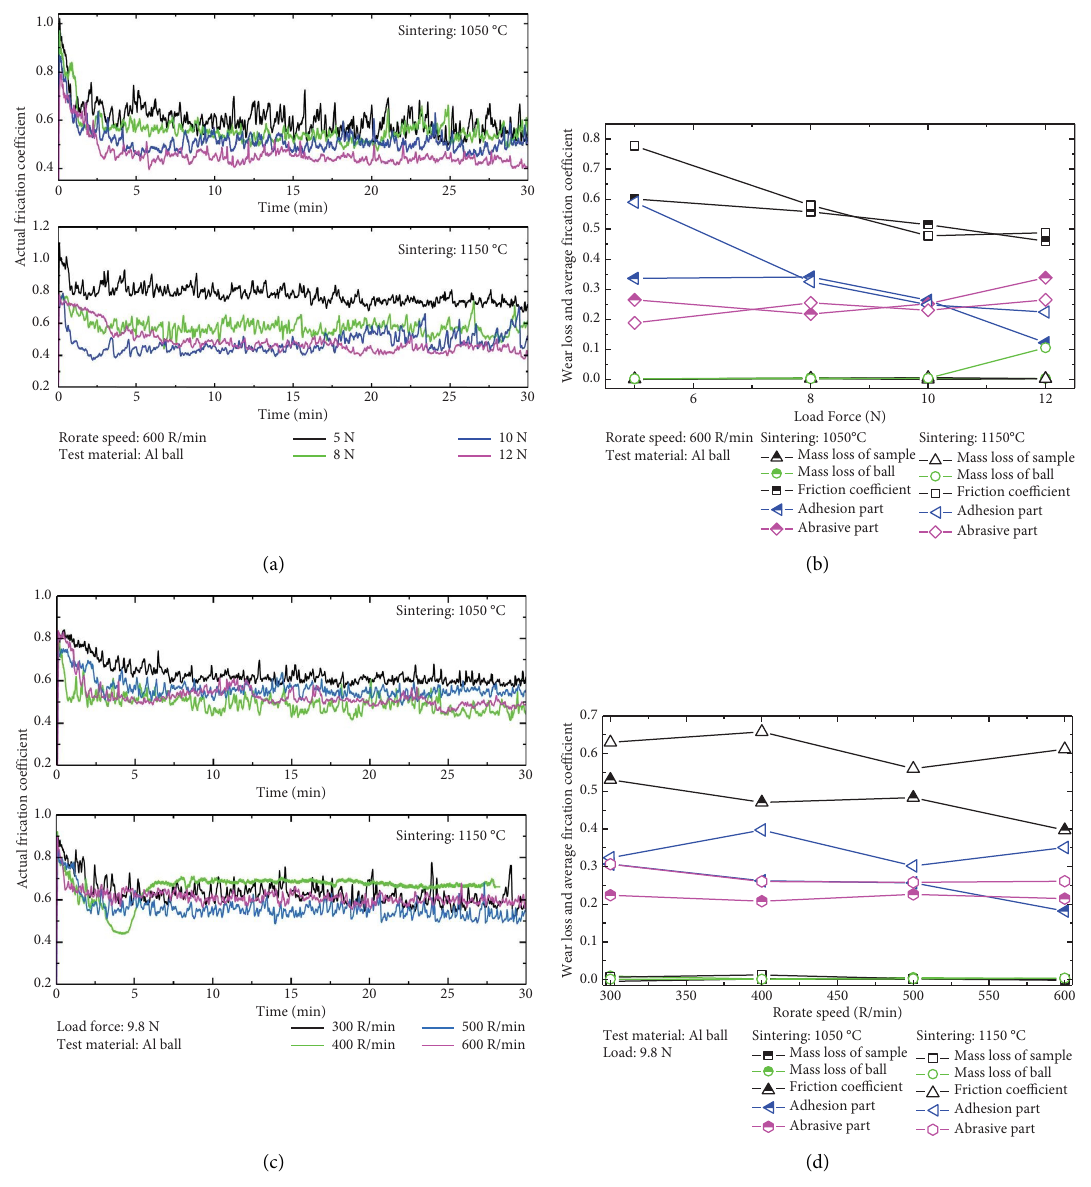
Figure 11: COF (a) and mass loss (b) of the composites with Al pair under 5–12N; COF (c) and mass loss (d) of the composites at